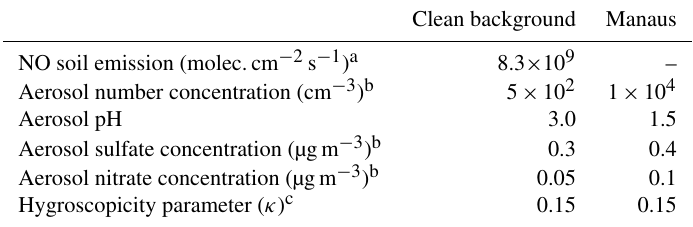
Table 1. Box model constraints used in the clean and polluted setups.